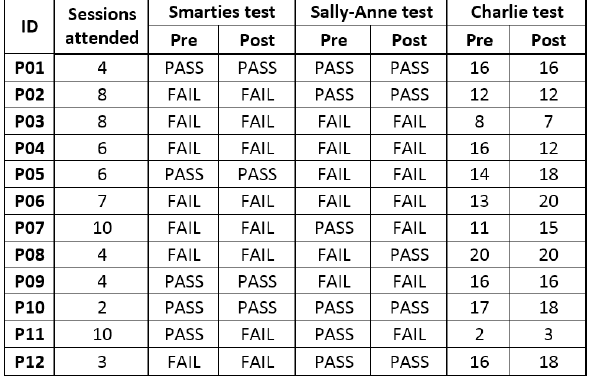
Figure 11: Child pre- and post-testing results.